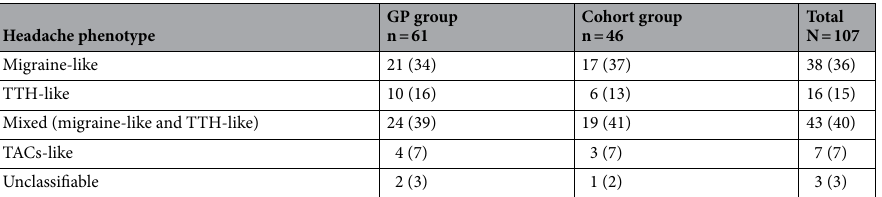
Table 2. Headache phenotypes of persistent post-traumatic headache* approximately 4 months after mild traumatic brain injury. Numbers in cells are n (%). *Classified according to the International Classification of Headache Disorders, 3rd edition. The percentages do not always add up to 100% due to rounding. GP general practitioner, TACs trigeminal autonomic cephalalgias, TTH tension-type